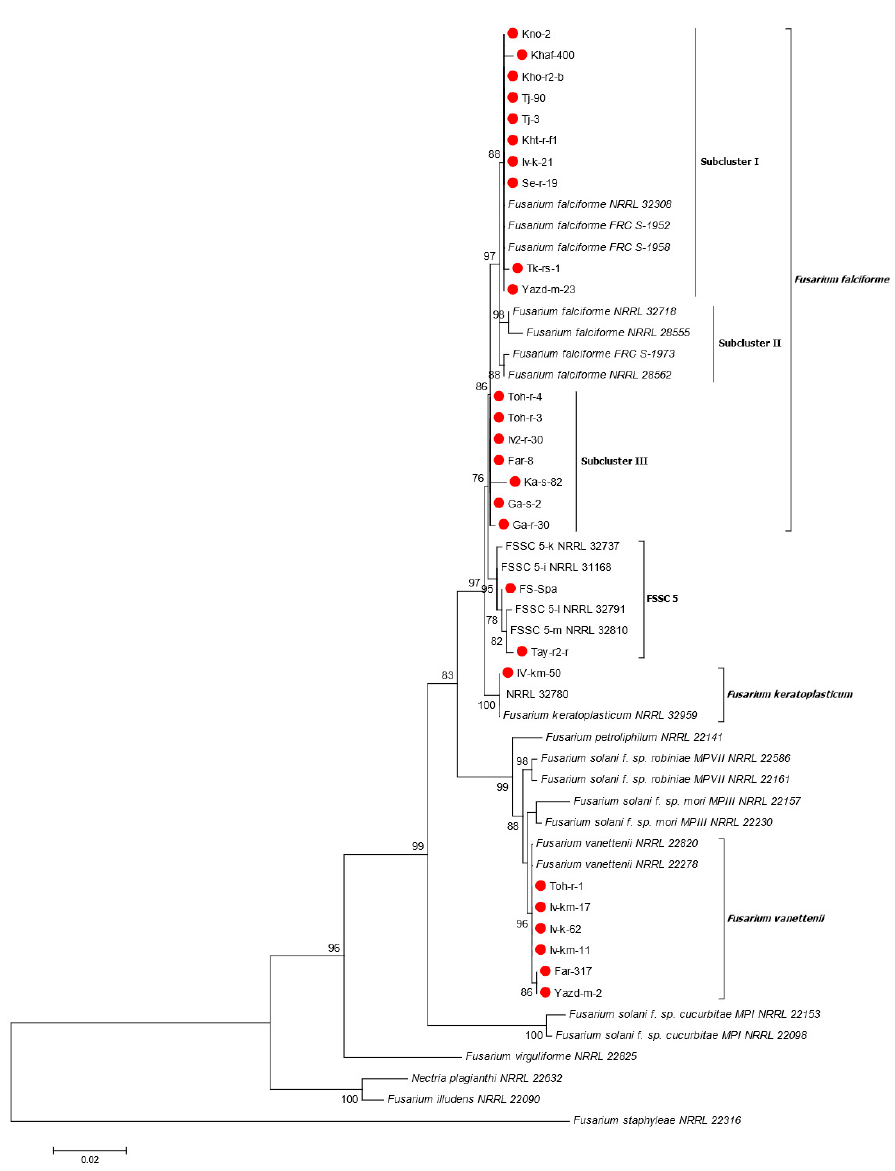
Figure 3. Maximum likelihood phylogeny of FSSC isolates from melons based on concatenated sequencing data of three gene regions (ITS, LSU, and tef1 ). Scale bar indicates number of substitutions per site. Bootstrap values higher than 70 are shown. Fusrium staphyleae (NRRL 22316) was used as the outgroup. Red dots indicate Iranian isolates recovered in this